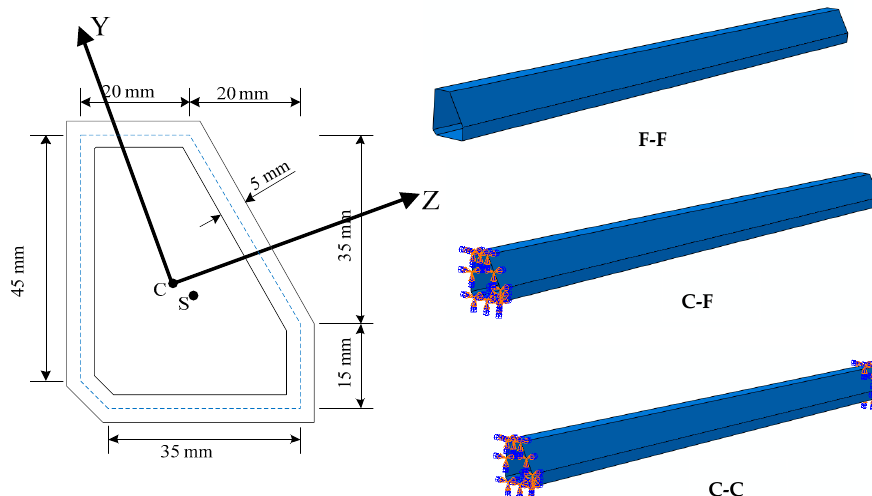
Figure 4. Beam numerical example